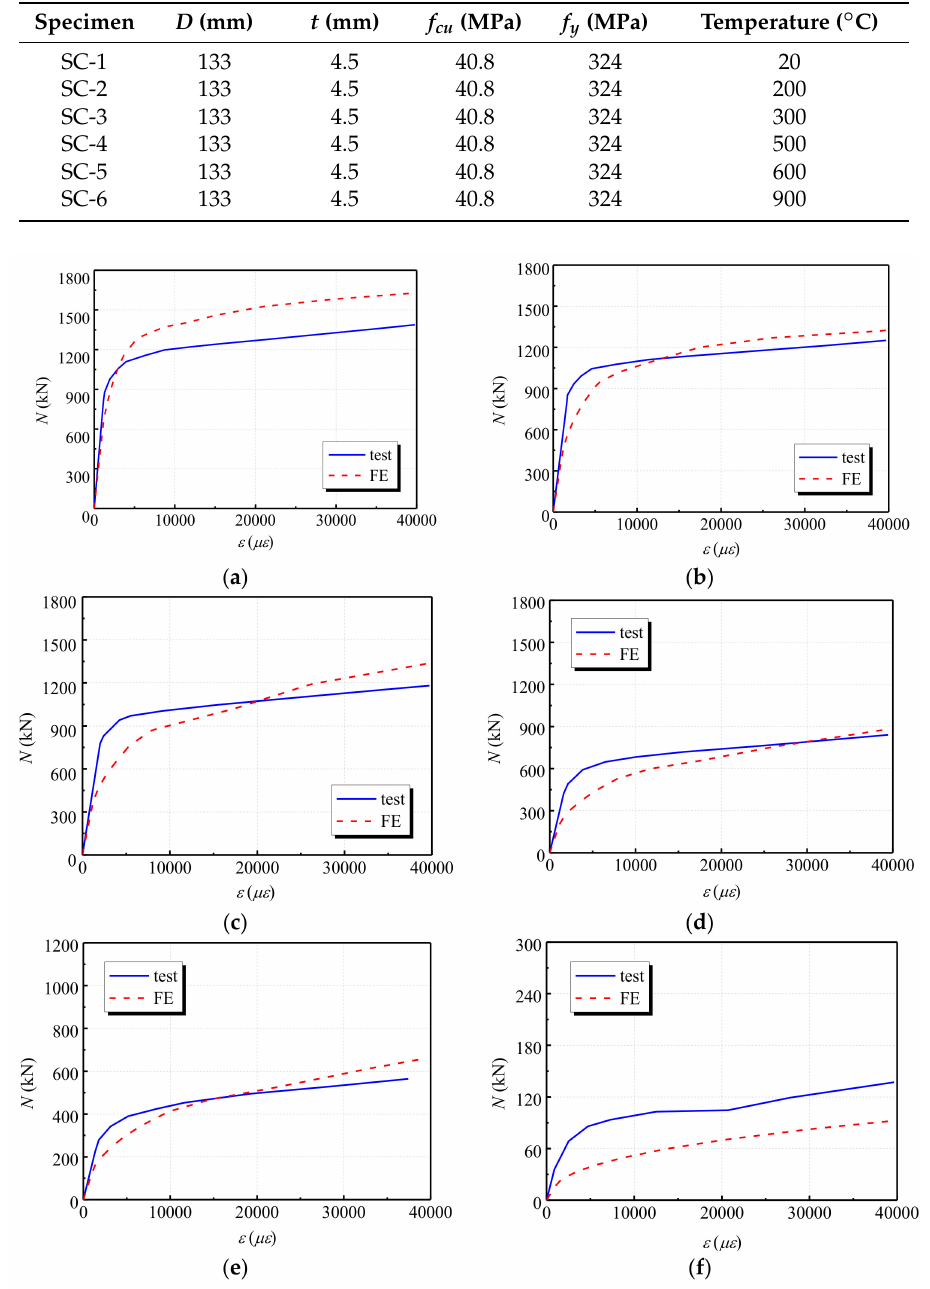
Figure 10. Load-strain curve comparisons between experimental and numerical results ( a ); SC-1 ( b ) SC-2; ( c ) SC-3; ( d ) SC-4; ( e ) SC-5; ( f )